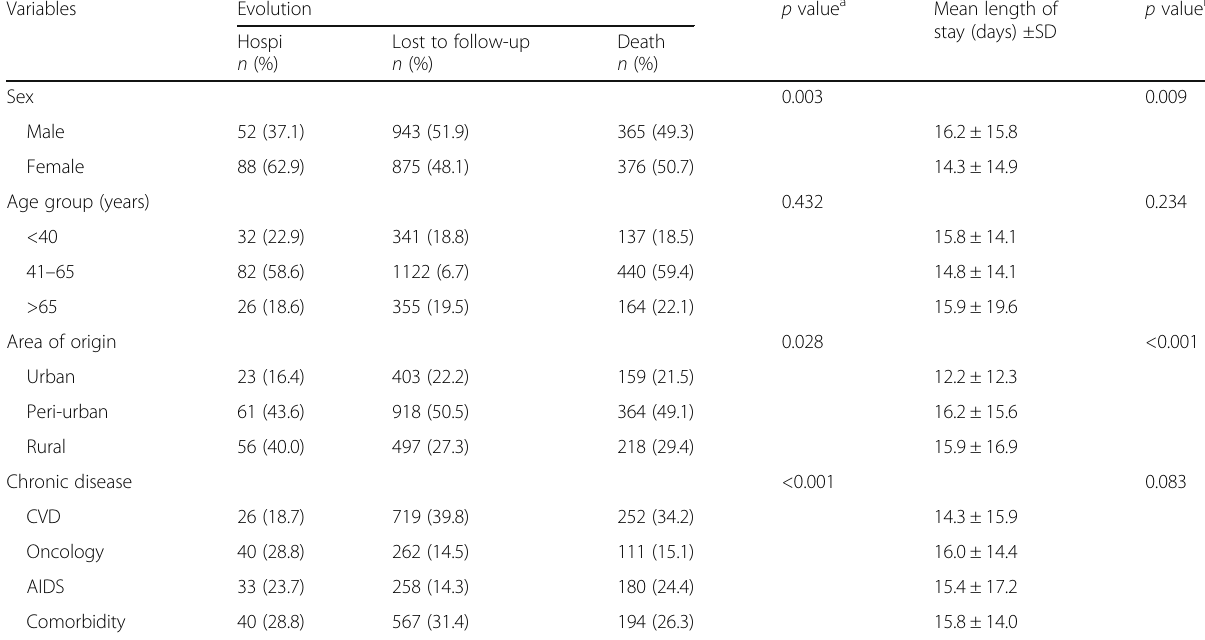
Table 2 Patients ’ evolution and length of stay according to sociodemographic characteristics and chronic conditions